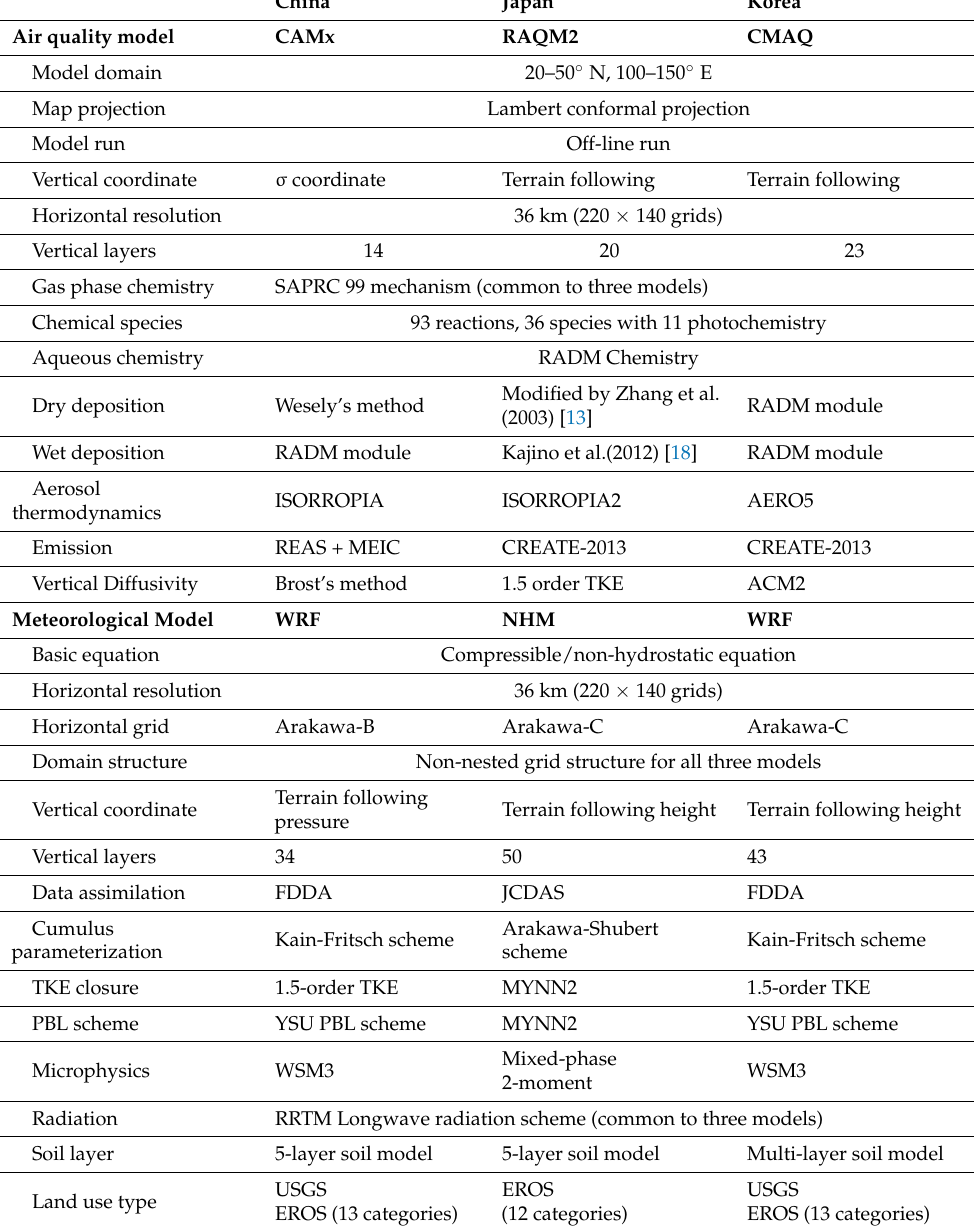
Table 1. Descriptions of the physical and chemical parameters of three models: WRF-CMAx (Weather Research and Forecasting-Comprehensive Air Quality Model with Extensions), NHM-RAQM2 (Non-Hydrostatic Model-Regional Air Quality Model2), and WRF-CMAQ (Weather Research and Forecasting-Community Multi-scale Air Quality Modeling System), employed by the Chinese, Japanese, and Korean modeling research groups,